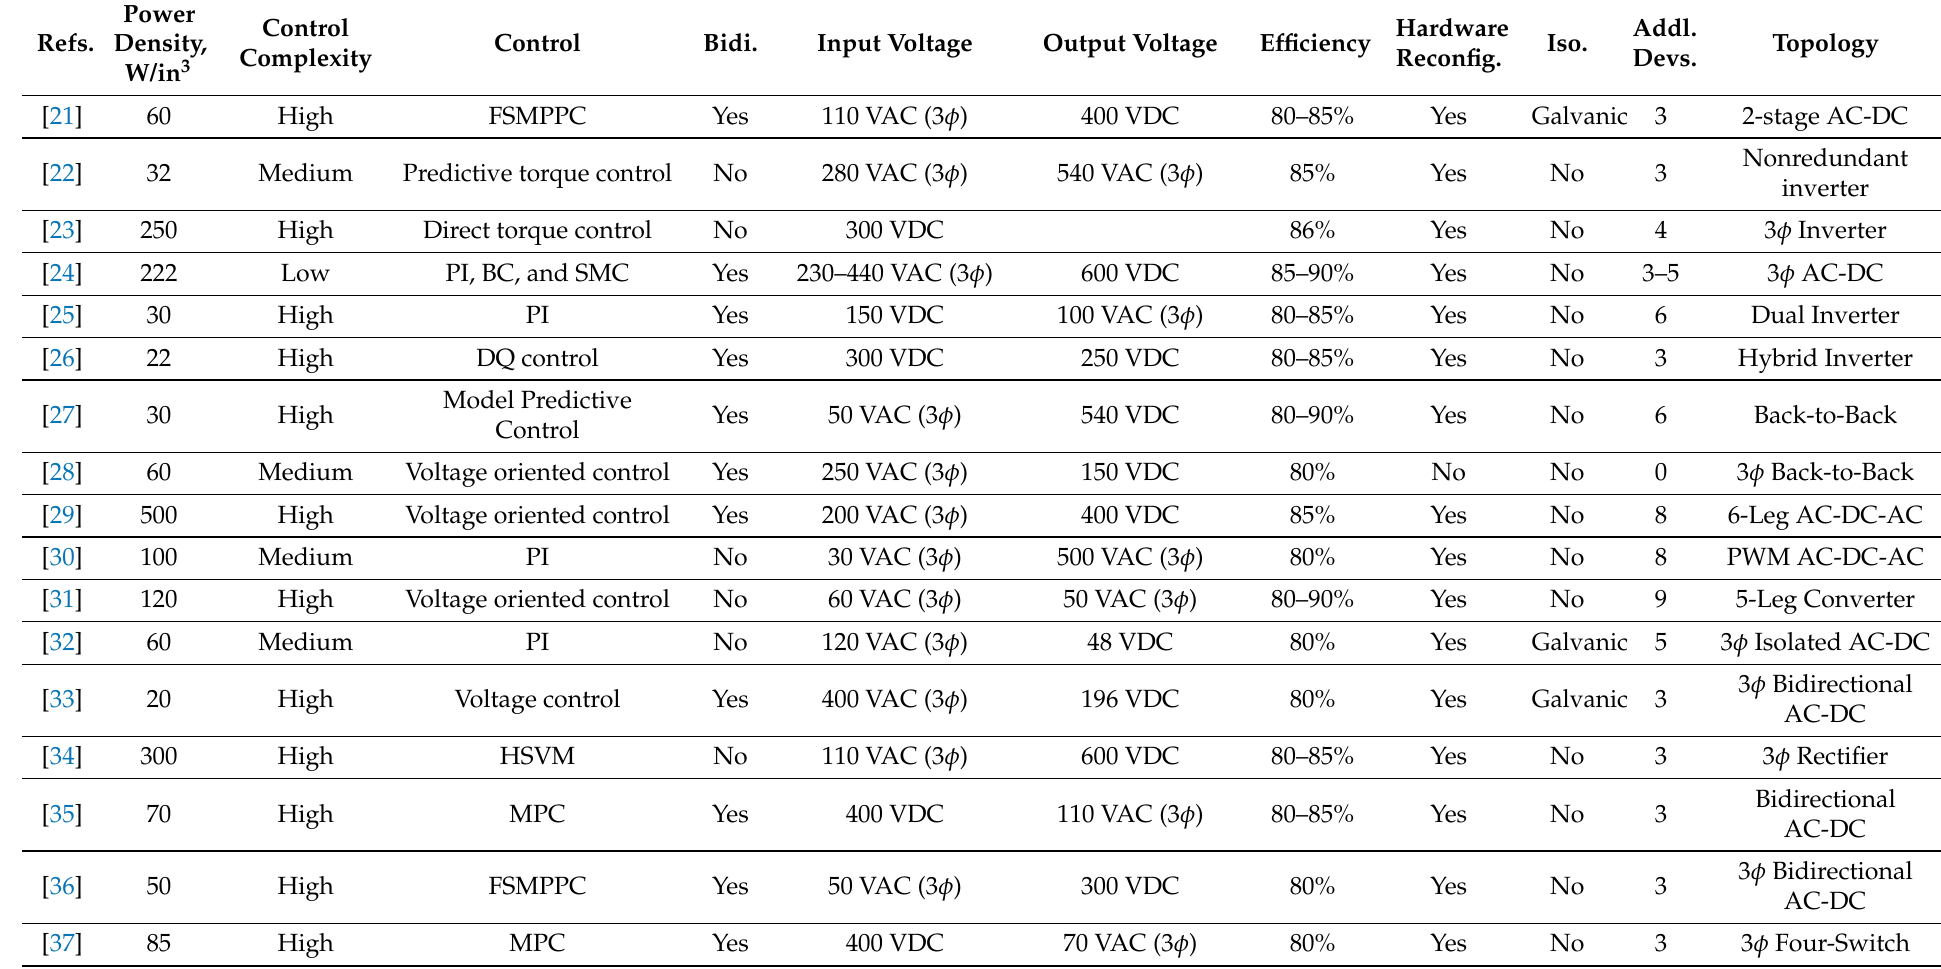
Table 2. Comparison of the different fault-tolerant leg-level